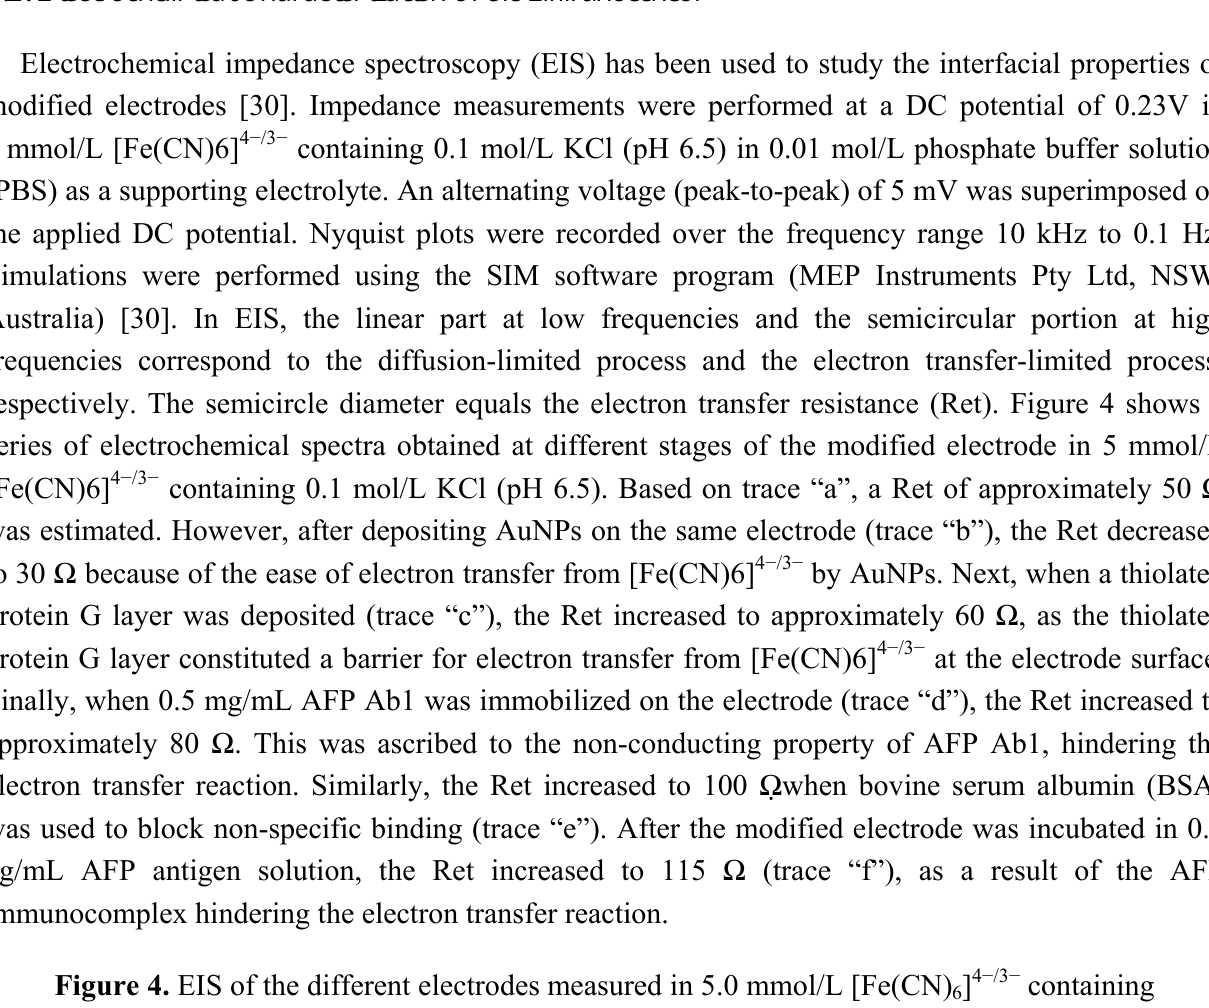
] 4 − /3 − containing 6